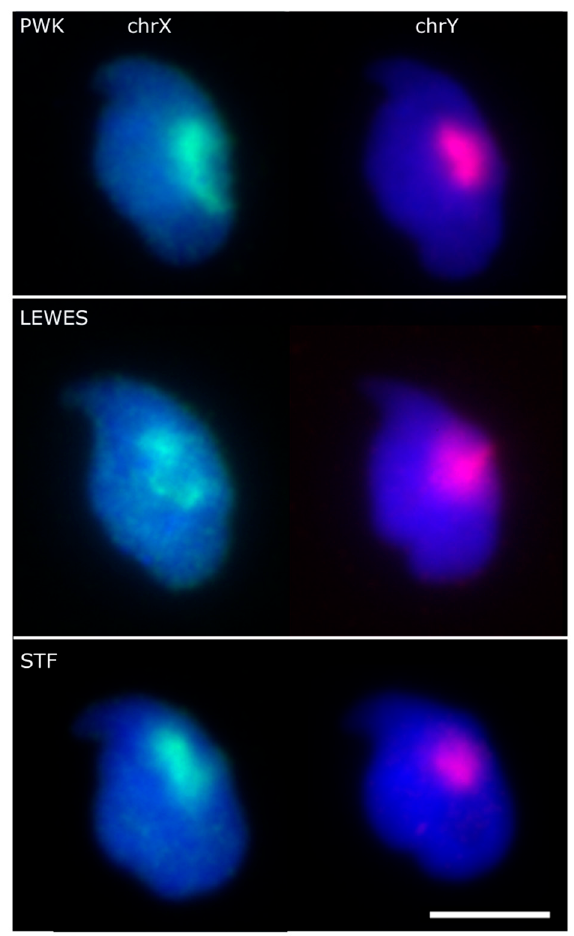
Figure 2. Example images showing the sex chromosome positions within the three strains. Scale bar represents 5 μ m.